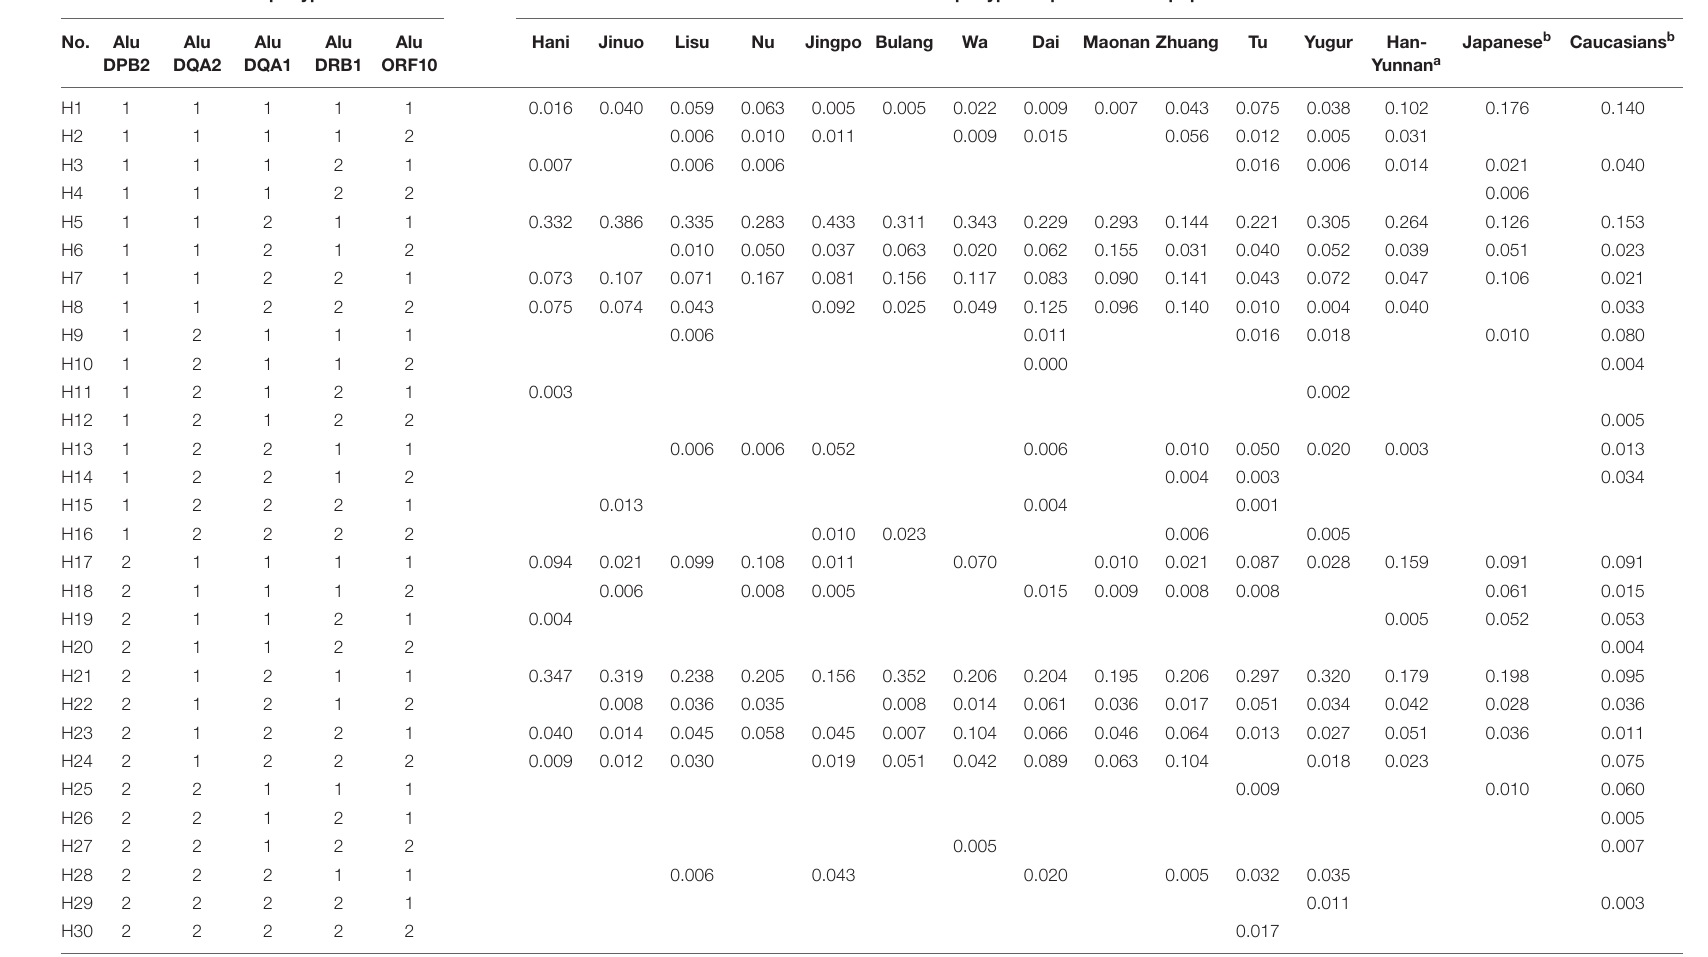
TABLE 4 | Haplotype frequencies of POALINs at five loci in 15